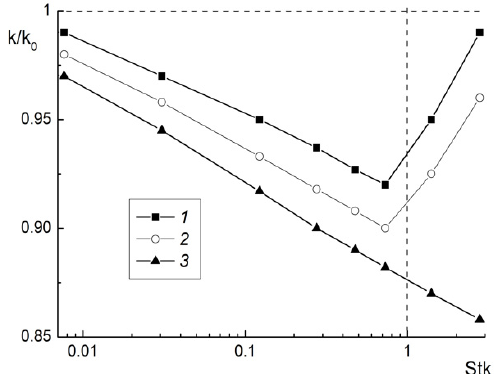
Figure 7. The TKE modification ratio vs. Stokes numbers at a few stations from the wall surface. x / H = 2, M L 1 = 0.05. 1: y / H = 0.1; 2: 0.5; 3: 1.